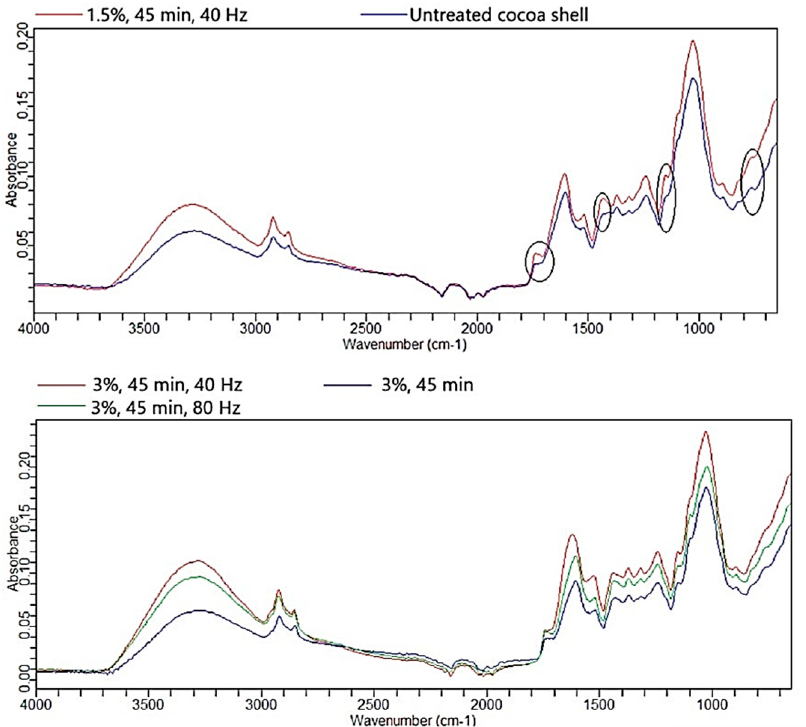
Figure 5. Representative Fourier transform infrared spectroscopy with attenuated total reflection (FTIR-ATR) spectra of cocoa shell before and after the HVED treatment.